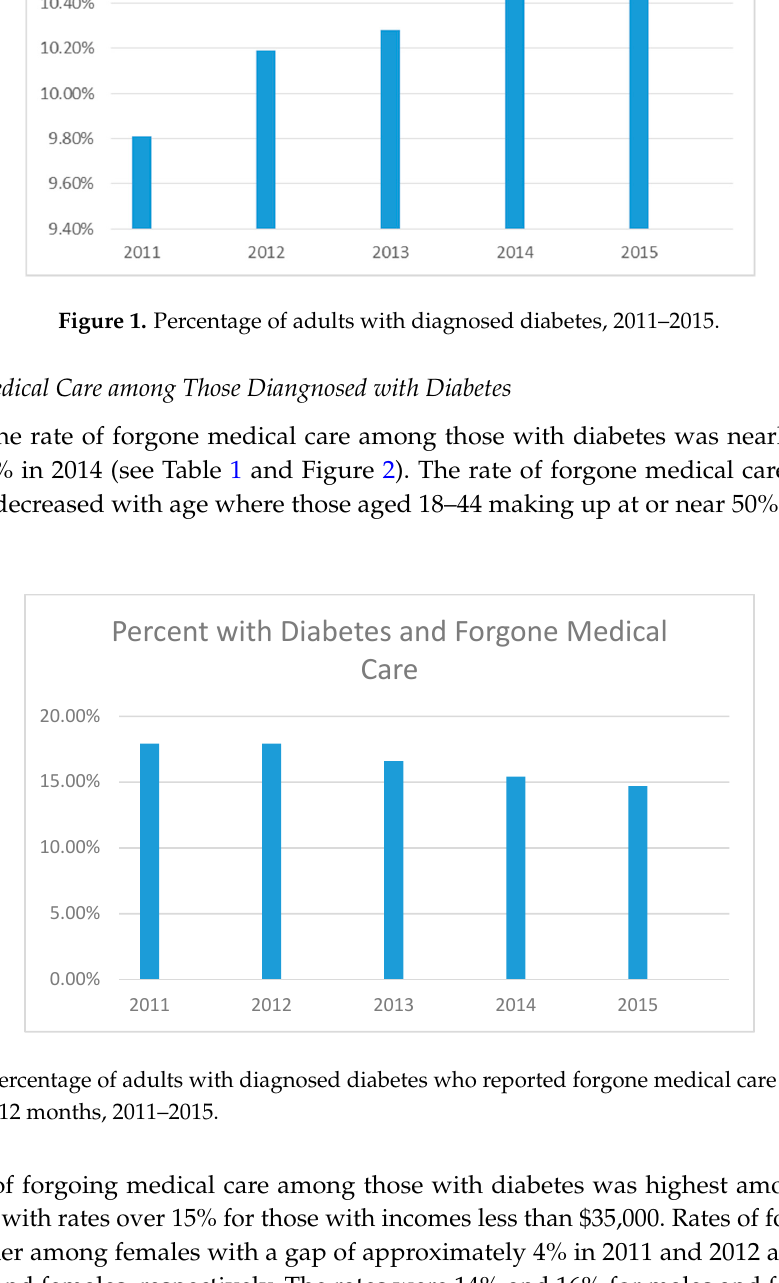
Figure 2. Percentage of adults with diagnosed diabetes who reported forgone medical care due to cost in the past 12 months,